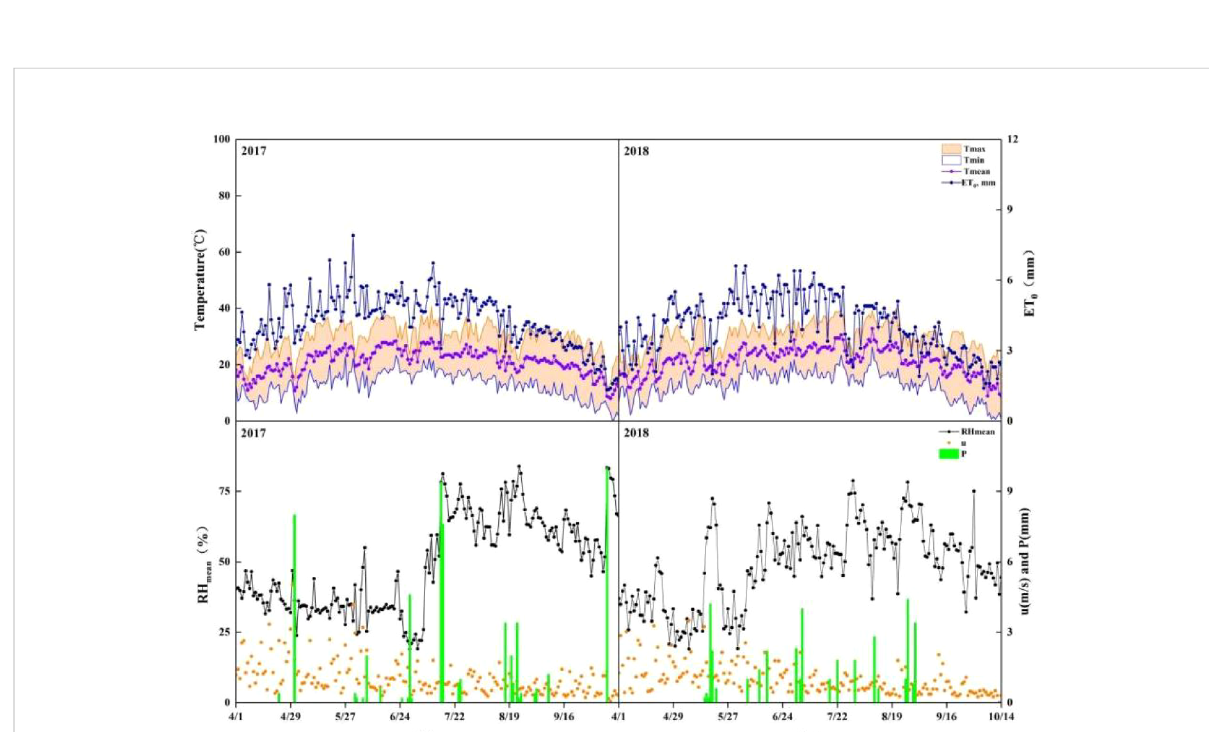
FIGURE 2 Meteorological data in 2017and 2018. ET 0 : Reference crop evapotranspiration; RH mean : Relative humidity; u : Wind speed; P : Precipitation.